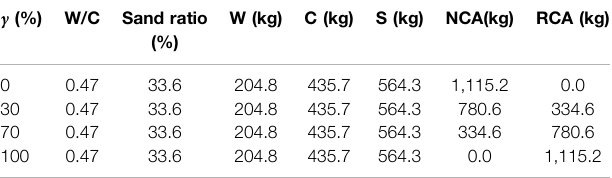
TABLE 2 | Mix proportions of RC.